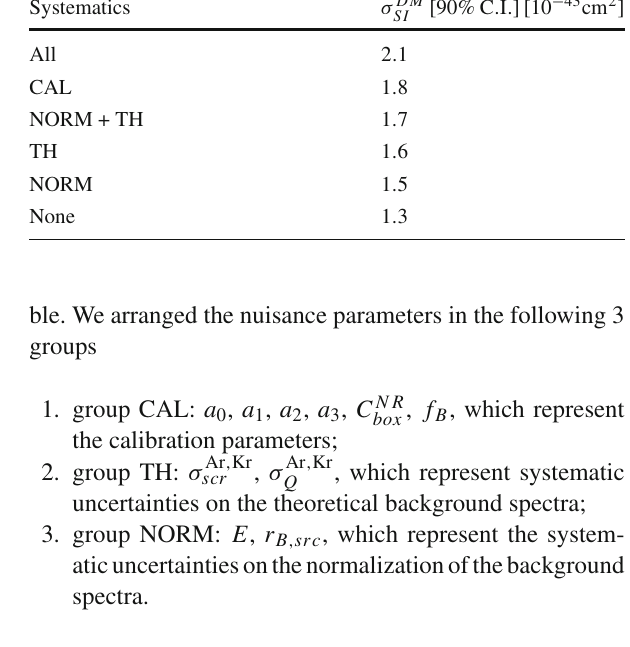
the expected pseudo-dataset and fixing different groups of systematic parameters, see text